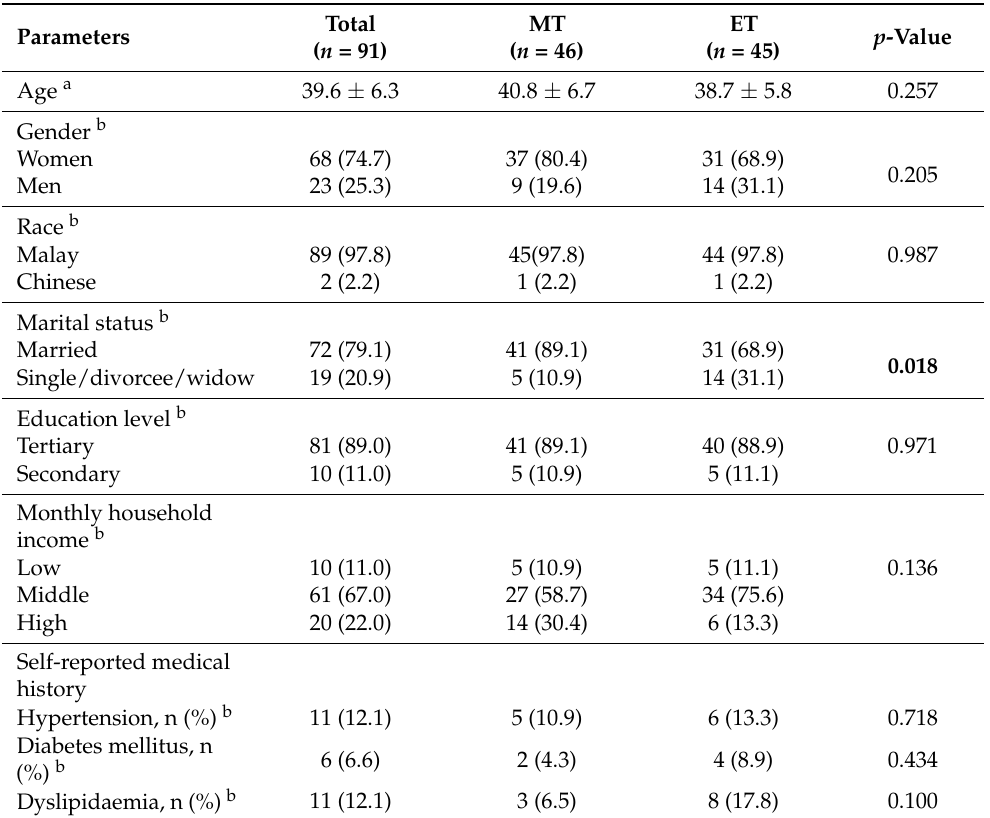
Table 3. Socio-demographic characteristic of